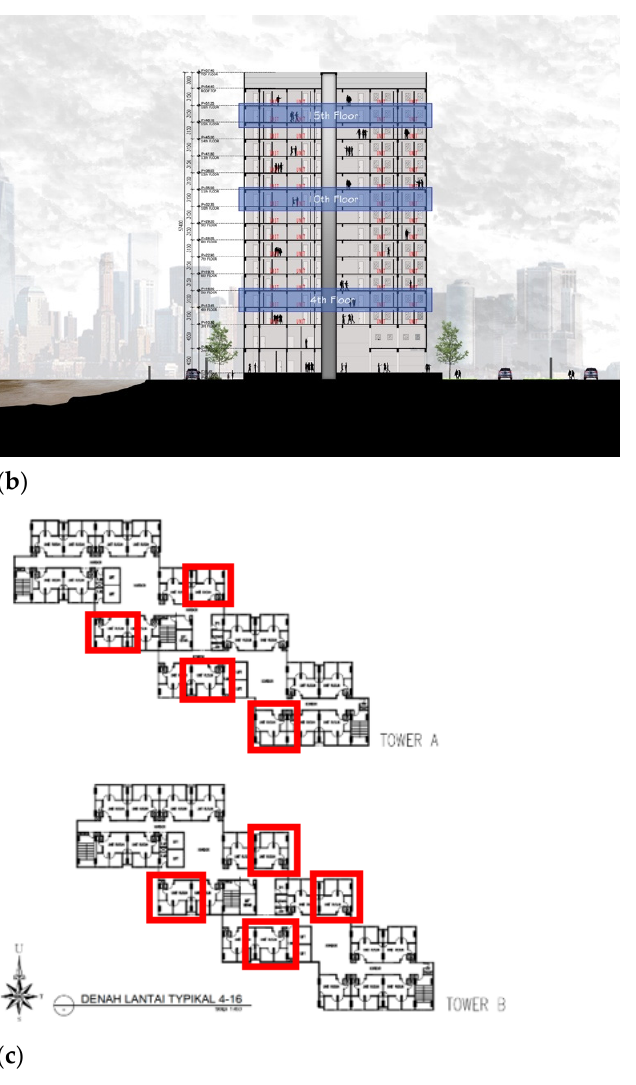
Figure 6. General data of the field measurement: ( a ) Field measurement points on residential units; ( b ) field-measured floor position; ( c ) field-measured residential unit.